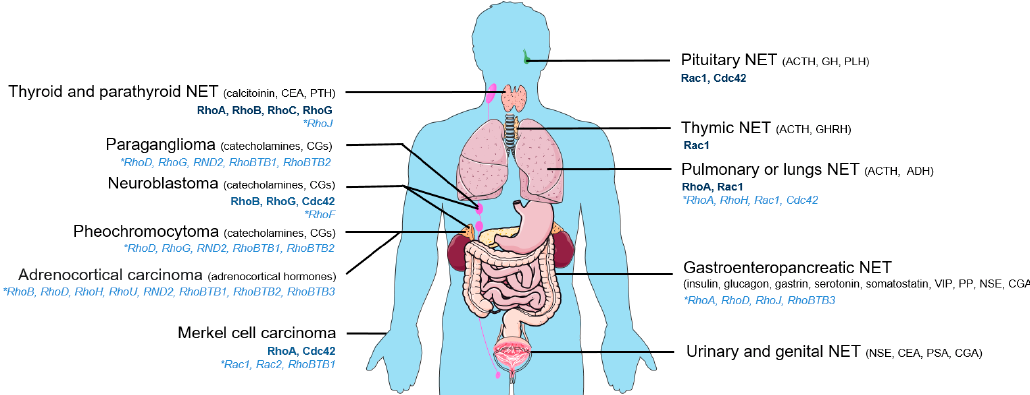
Figure 1. Main types of neuroendocrine tumors (NETs). Mutated Rho GTPases (light blue) or Rho GTPases for which expression level varies (dark blue) are indicated for each NET along with main